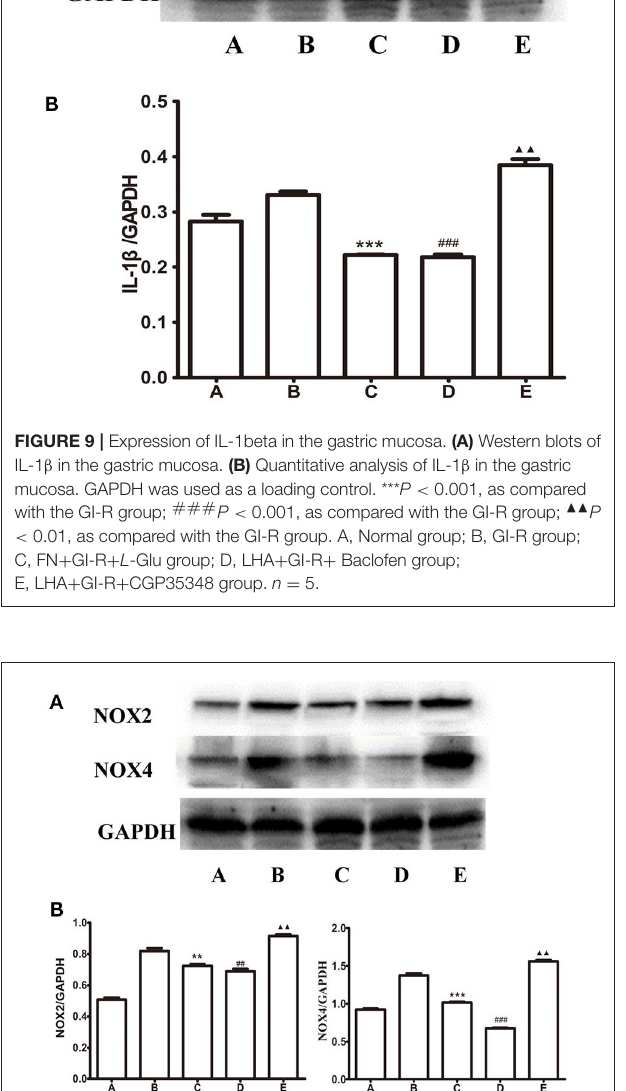
and apoptosis after microinjection of the GABA A R agonist. In